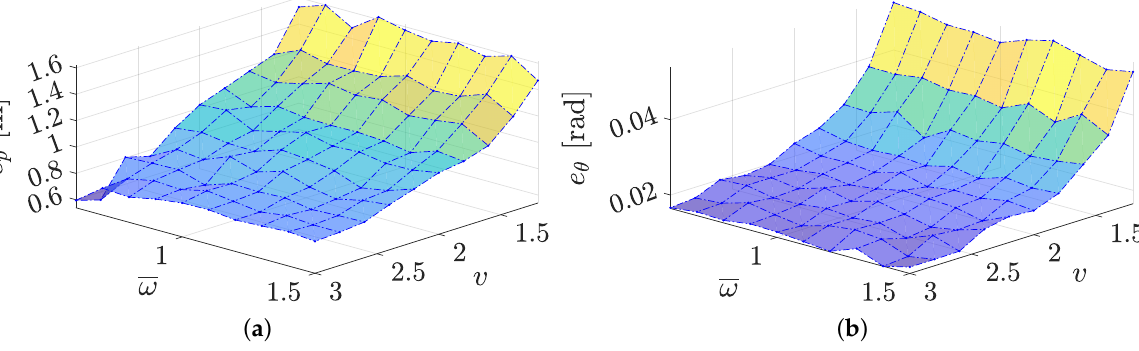
Figure 10. ( a ) Position and ( b ) orientation RMSE for different values of the angular and linear